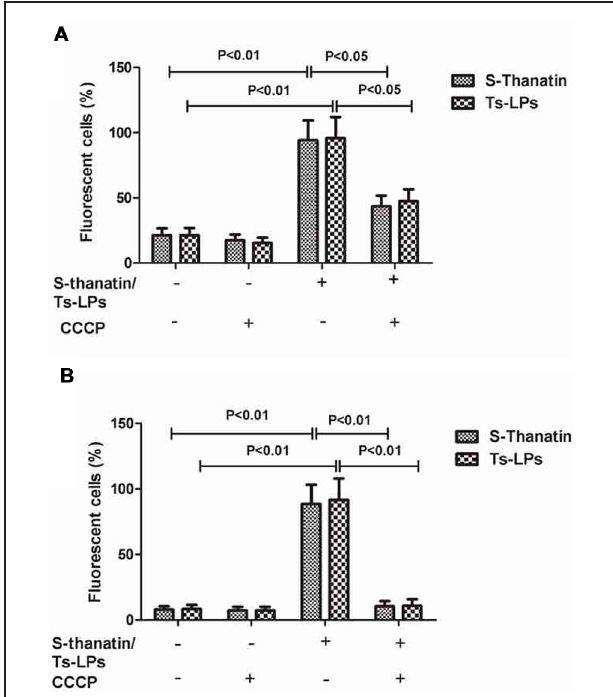
FIGURE 5 | Ts and Ts-LPs affecting membrane permeability of K. pneumoniae ATCC 700603. Bacteria incubated with Ts or Ts-LPs-LEV following by staining with (A) PI or (B) DiBAC4(3). The error bars represent SD ( n = 5).